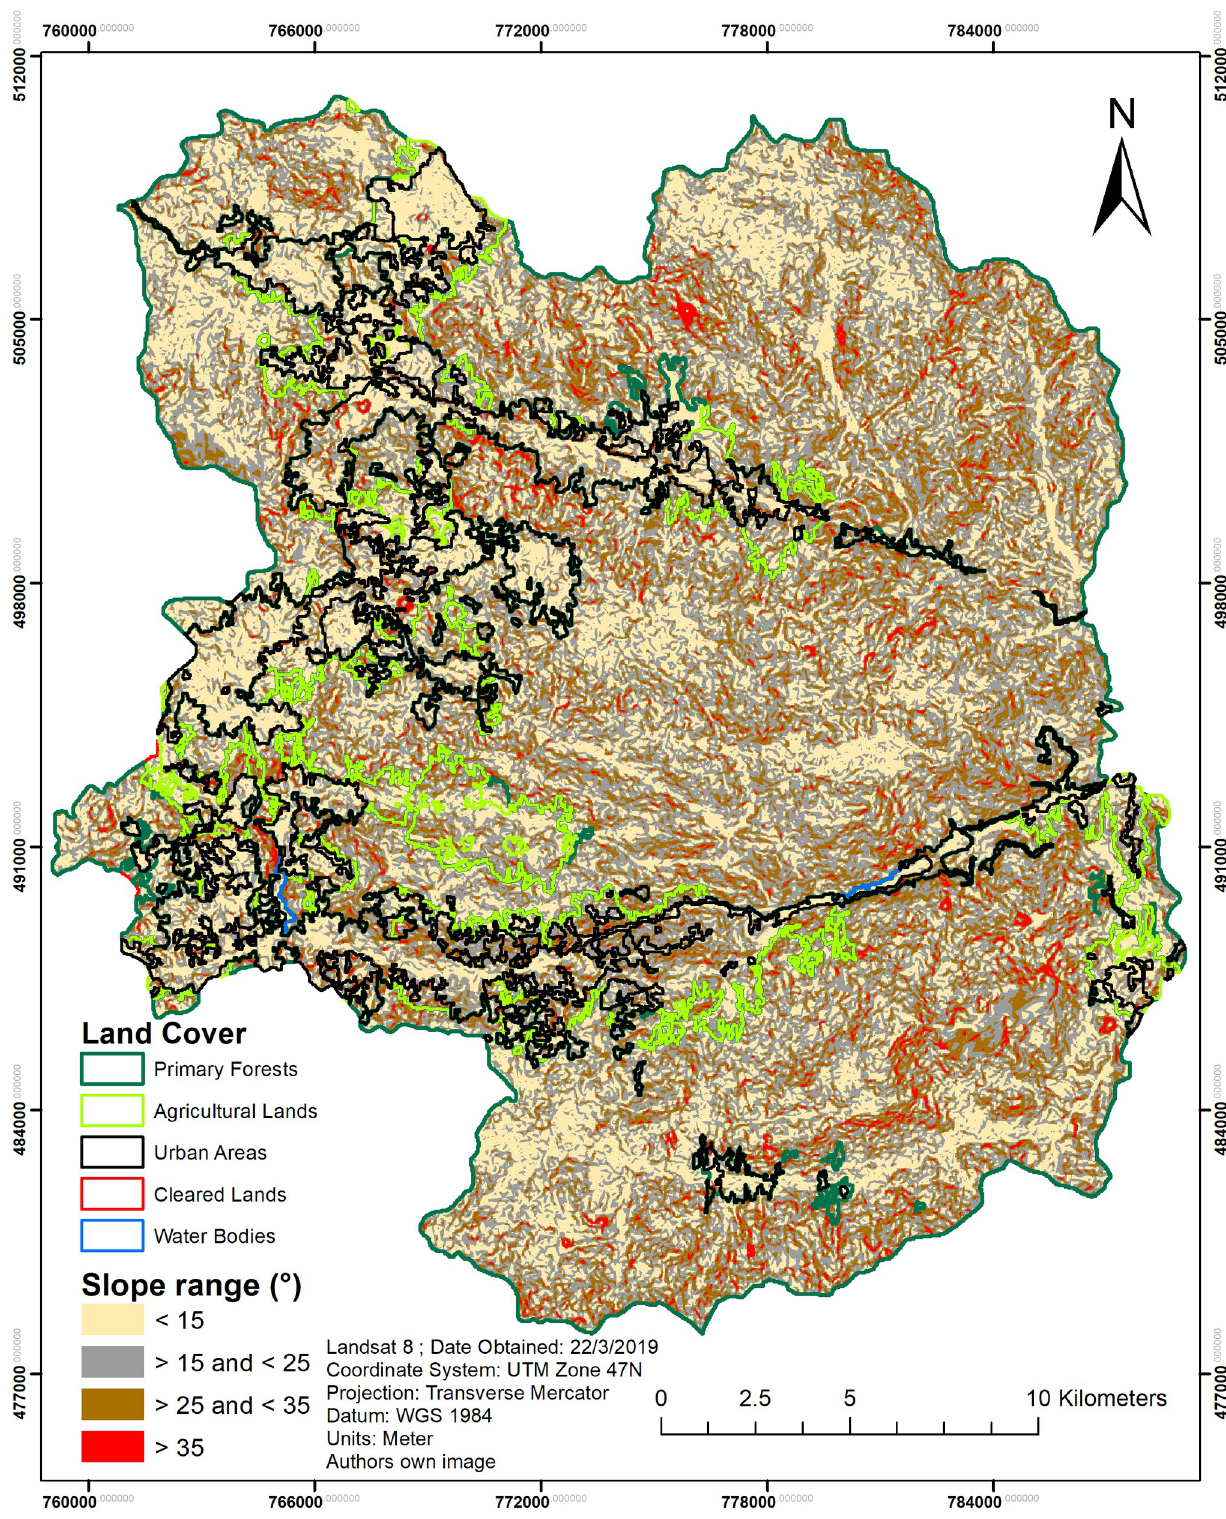
Fig 5. Cameron Highlands slope and land cover image overlay. (Data source: Landsat-8 OLI image courtesy of the U.S. Geological Survey).